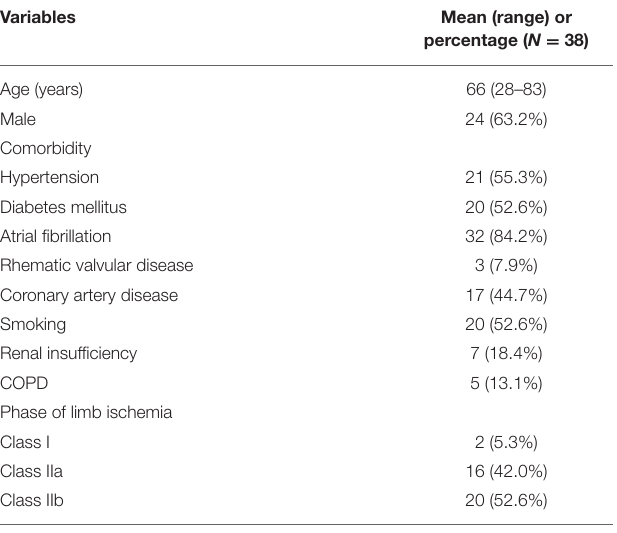
TABLE 1 | Patients’ demographics.